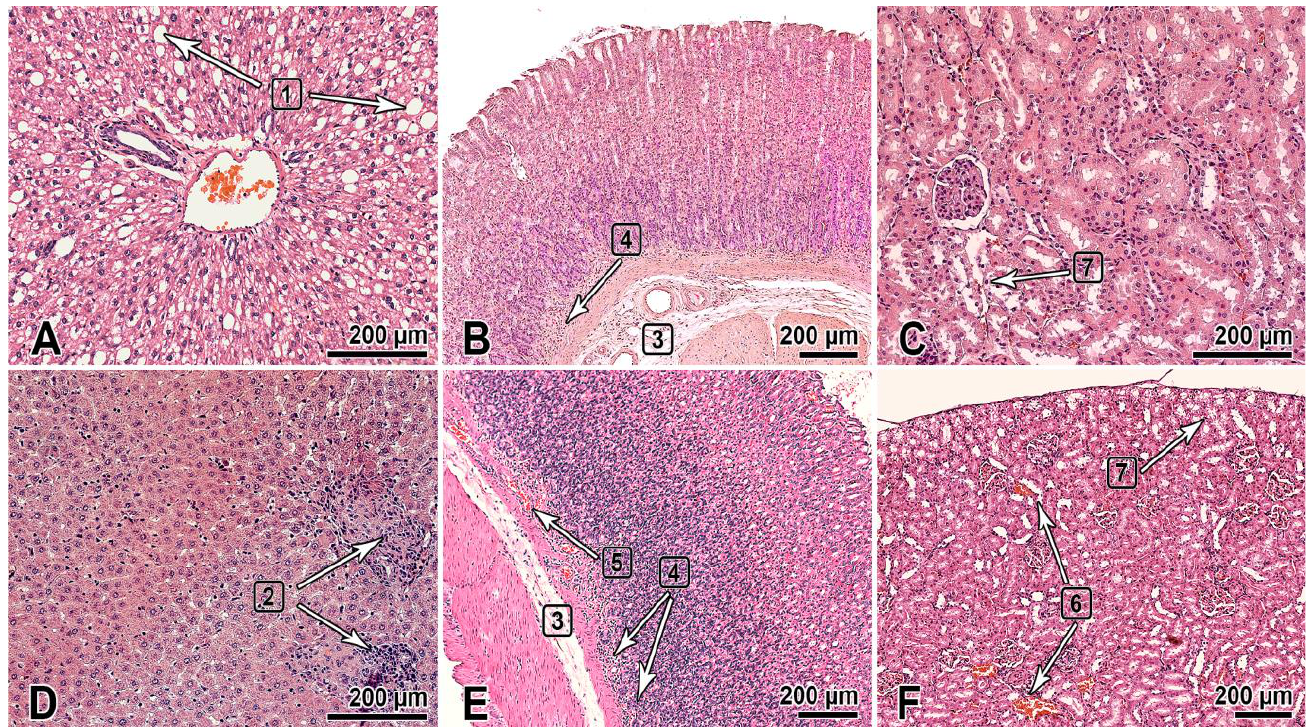
Figure 1. The organs of rats 1 day after the multiple-dose administration of the substance NIOCH-14 (150 µg/g body weight) once daily during 30 days was stopped. ( A – C ) — males; ( D – F ) — females. The bar is shown in the images. Hematoxylin and eosin staining. The liver ( A , D ): dystrophic changes in hepatocytes (steatosis) (1), foci of post-necrotic changes — fibrosis and lymphocytic infiltration (2). The gastric fundus mucosa ( B , E ): Gastric submucosa edema (3), mononuclear cell infiltration of the deep mucosa (4), and hyperemia (5). The renal cortex ( C , F ): hyperemia of renal cortical vessels (6) and vacuolar dystrophy with degeneration of the cytoplasm in the renal proximal tubular epithelium (7).